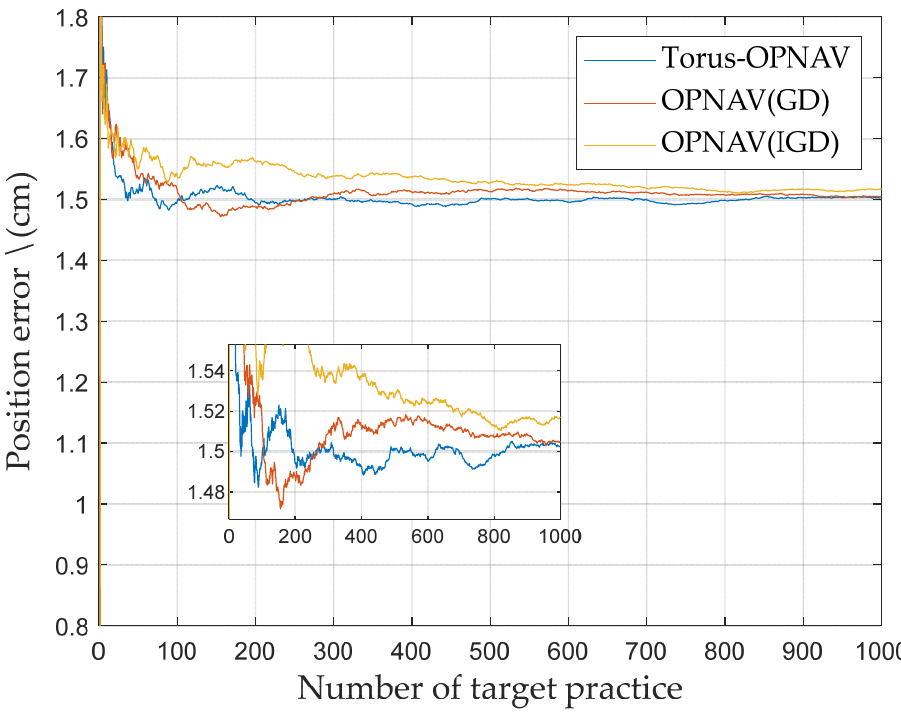
Figure 15. Position error of Torus-OPNAV, OPNAV(GD), and OPNAV(IGD).